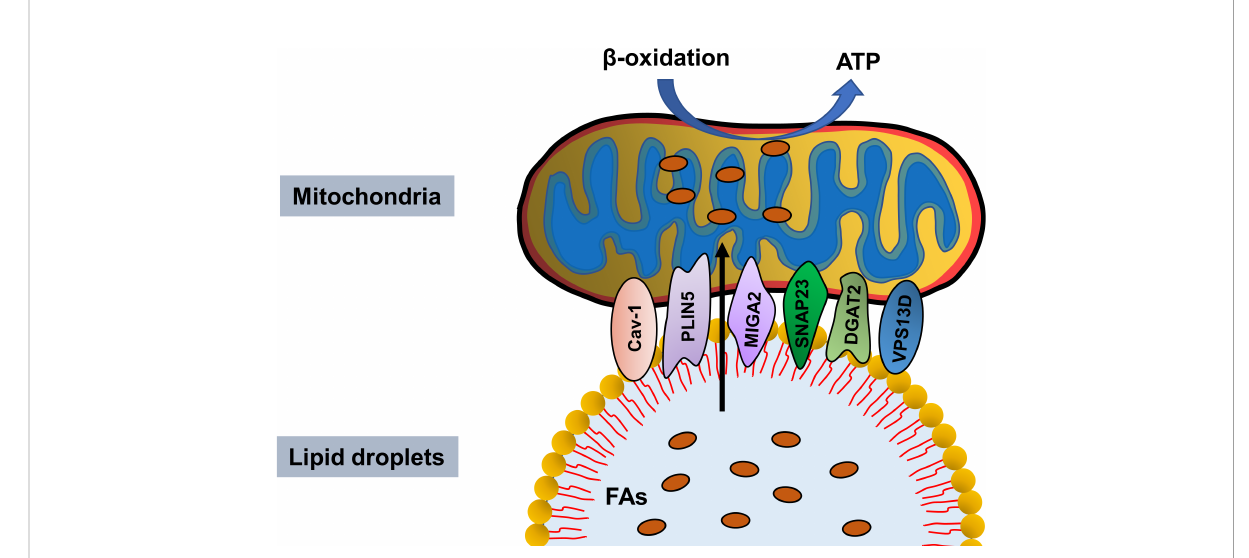
FIGURE 1 Proteins mediating lipid droplet and mitochondria integrity. Cav-1, PLIN5, MIGA2, SNAP23, DGAT2 and VPS13D maintain lipid droplet – mitochondria connection, thus facilitating fatty acids transfer in from lipid droplet to mitochondria for b -oxidation and ATP